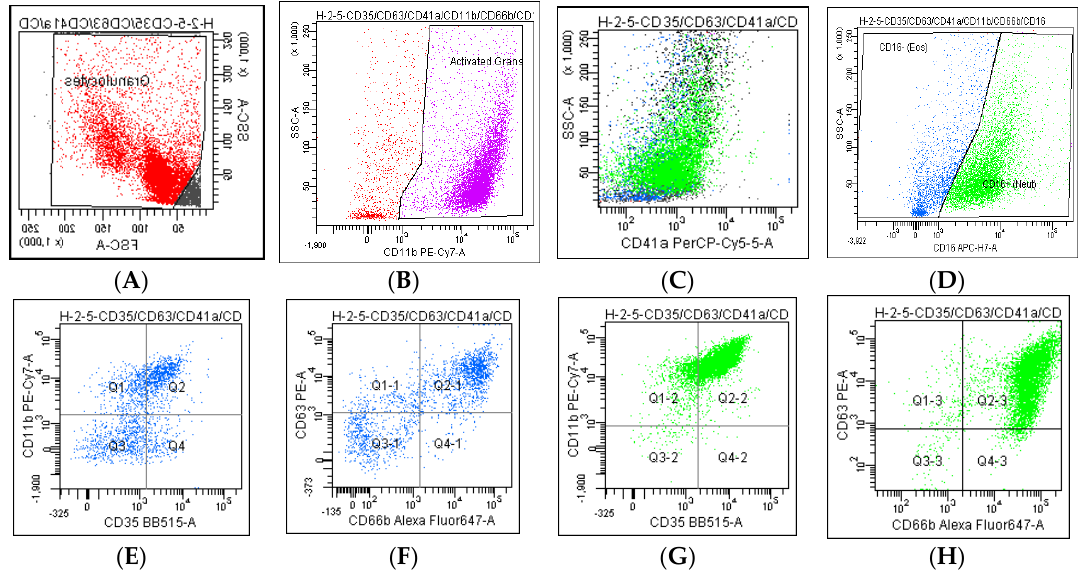
Figure 1. Gating strategy to identify activated sputum granulocytes. ( A ) A forward-/side-scatter (FSC/SSC) gate to identify the granulocytes. ( B ) The activated granulocytes were based on CD11b+. ( C ) CD41a was gated with SSC to confirm that the activated granulocytes were neutrophils and eosinophils. ( D ) Subsequently, the eosinophils (blue) and neutrophils (green) were separated based on the expression of CD16− and CD16+ on SSC, respectively. The activation markers of CD11b, CD35, CD63, and CD66b for eosinophils ( E , F ) and neutrophils ( G , H ) were based on the negative gates of the isotype control for all antibodies.